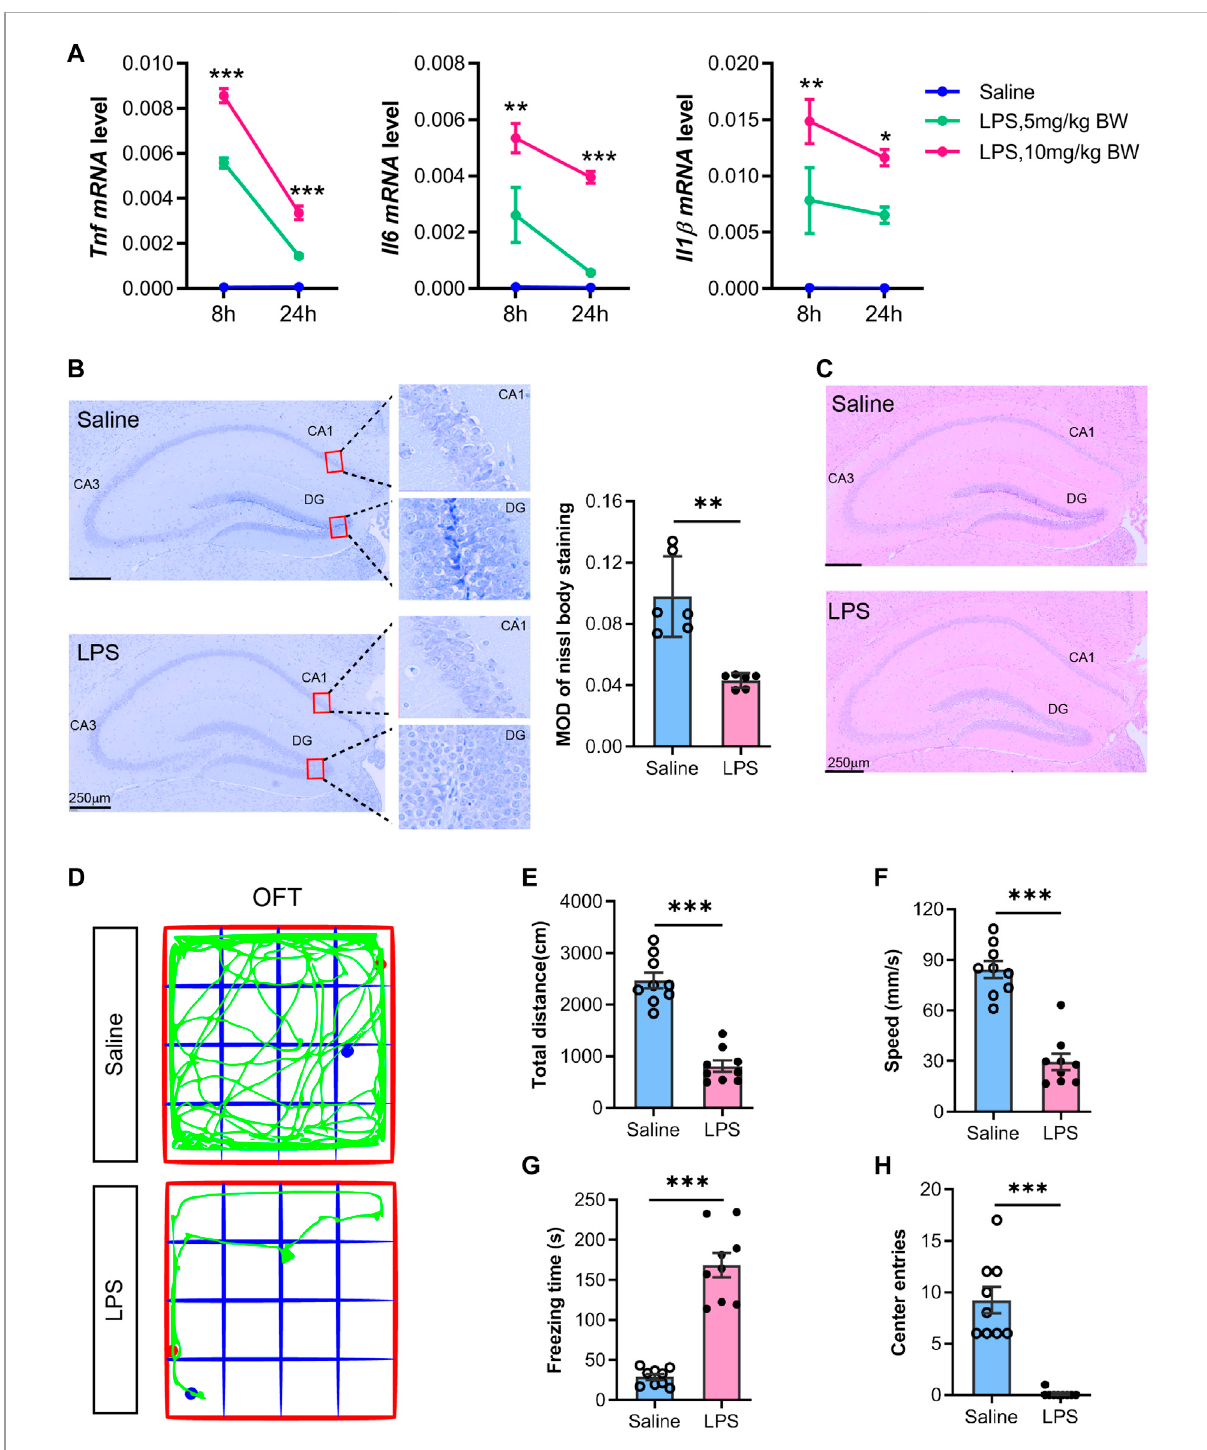
FIGURE 1 Proin fl ammatory cytokines and morphological alterations in the hippocampus with neurobehavior changes in mice undergoing acute sepsis phase. (A) RT-qPCR analysis of proin fl ammatory cytokines ( TNF , IL6, and IL1B ) alteration in the hippocampus from saline- or LPS-injected (5 or 10 mg/kg body weight) mice. The mRNA expression was normalized to GAPDH . Data are presented as mean ± SEM ( n = 3). Two-way ANOVA with Tukey ’ s multiple comparisons tests, * p < 0.05, ** p < 0.01, *** p < 0.001 (compared with LPS 5 mg/kg body weight at indicated time points). (B) Representative Nissl staining of the hippocampus from saline- or LPS-injected mice. The mean optical intensity was quanti fi ed and tested with an unpaired t -test. Data are presented as mean ± SEM (two sections per mouse, n = 6), ** p < 0.01. Bar 250 µm. (C) Hematoxylin-eosin staining of the